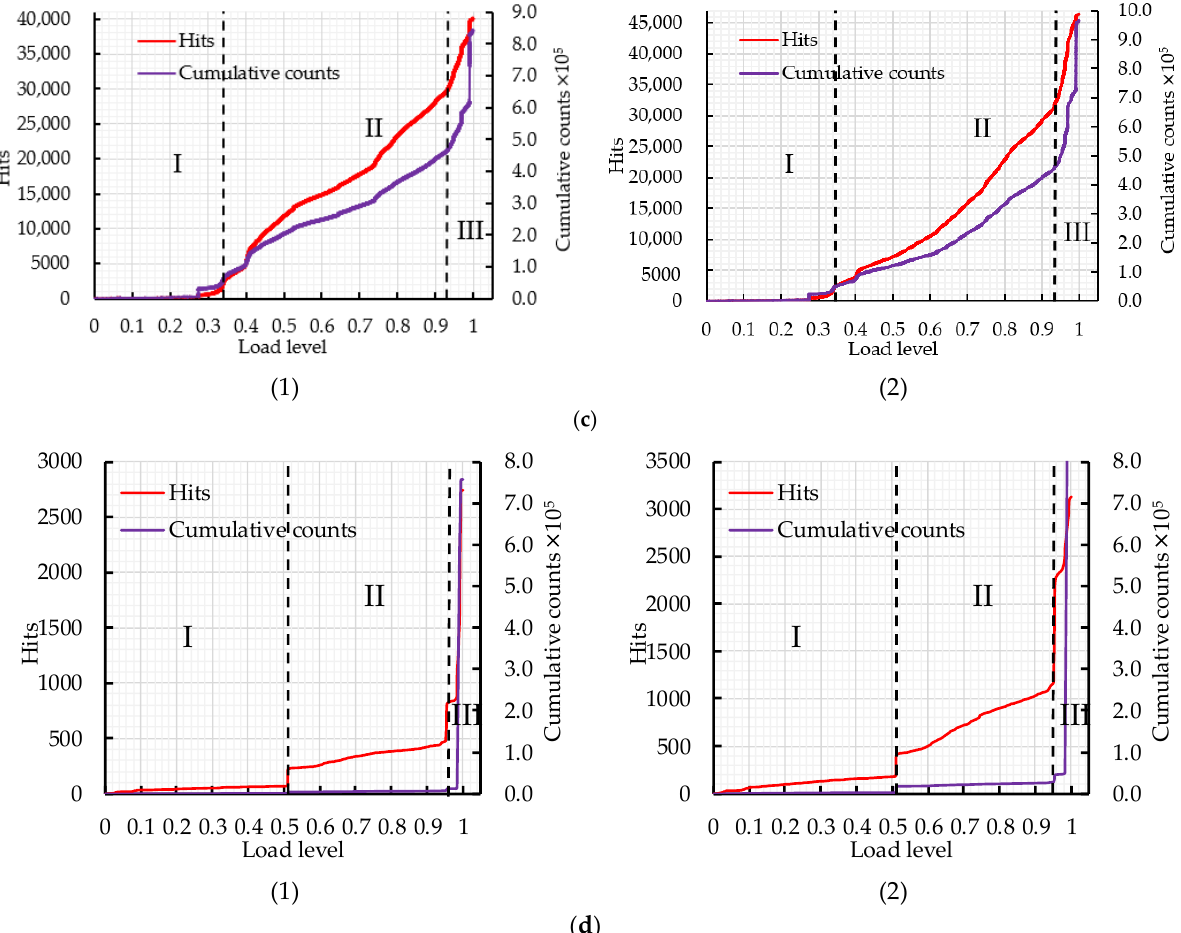
Figure 7. The variation curve of hits and cumulative counts: ( a ) RPC; ( b ) SBRPC-1; ( c ) SBRPC-3; ( d ) SBRPC-5.